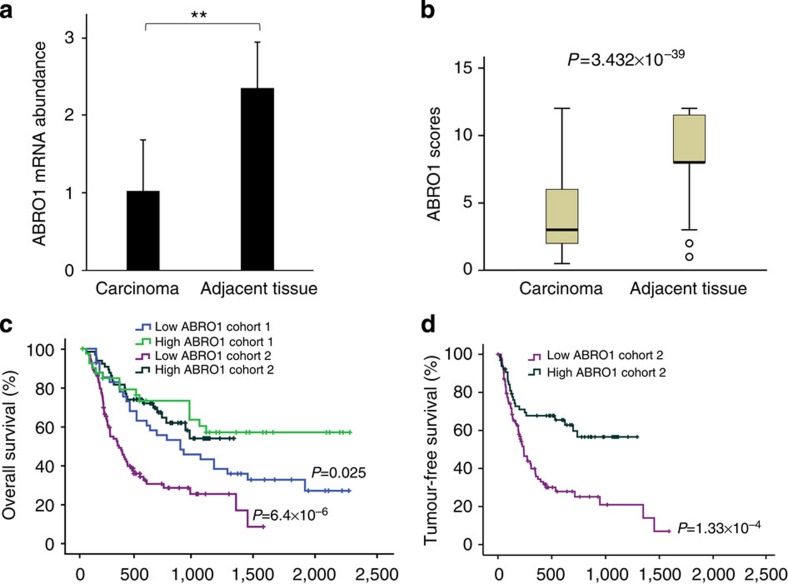
ABRO1 is frequently downregulated in human liver cancer tissues.(a) Quantitative RT–PCR analysis of ABRO1 mRNA levels in liver cancer tissues and corresponding adjacent tissue from 22 HCC patients. Data were analysed using Student’s t-test and are shown as the mean±s.d. **P<0.01. (b) ABRO1 expression scores shown as box plots, with the horizontal lines representing the median; the bottoms and tops of the boxes represent the 25th and 75th percentiles, respectively, and the vertical bars represent the range of data. Comparison was performed using the Mann–Whitney U-test. n=310. (c,d) Low ABRO1 expression correlates with poor survival of HCC patients. Kaplan–Meier survival curves of overall survival in Cohort 1 and Cohort 2 (c) and tumour-free survival in Cohort 2 (d) are shown. Comparison was made between groups with high ABRO1 expression (score≥9) and low ABRO1 expression (score<9). The marks on the graph lines represent censored samples. P-value refers to two-sided log-rank tests.